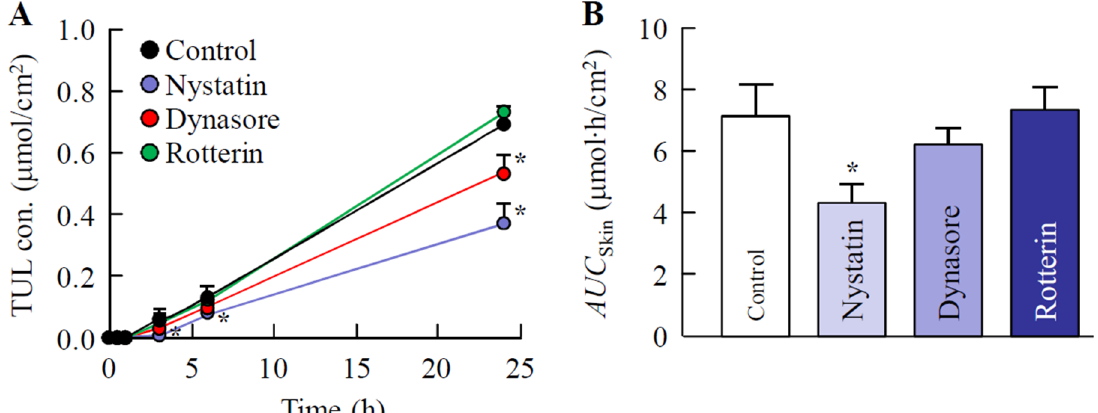
Figure 6. Effect of energy-dependent endocytosis on the transdermal penetration of TUL in the Men-WS/TUL-NP ointment. Changes in the TUL profiles ( A ) and AUC Skin values ( B ) of the Men-WS/TUL-MP ointment after treatment with endocytosis inhibitors (nystatin, dynasore, and rottlerin). The composition of the Men-WS/TUL-NP ointment is presented in Table 1. Results are means ± SE; n = 6–8. * p < 0.05 vs. control for each category. The transdermal penetration of TUL-NPs was significantly inhibited by treatment with CavME inhibitor (nystatin).